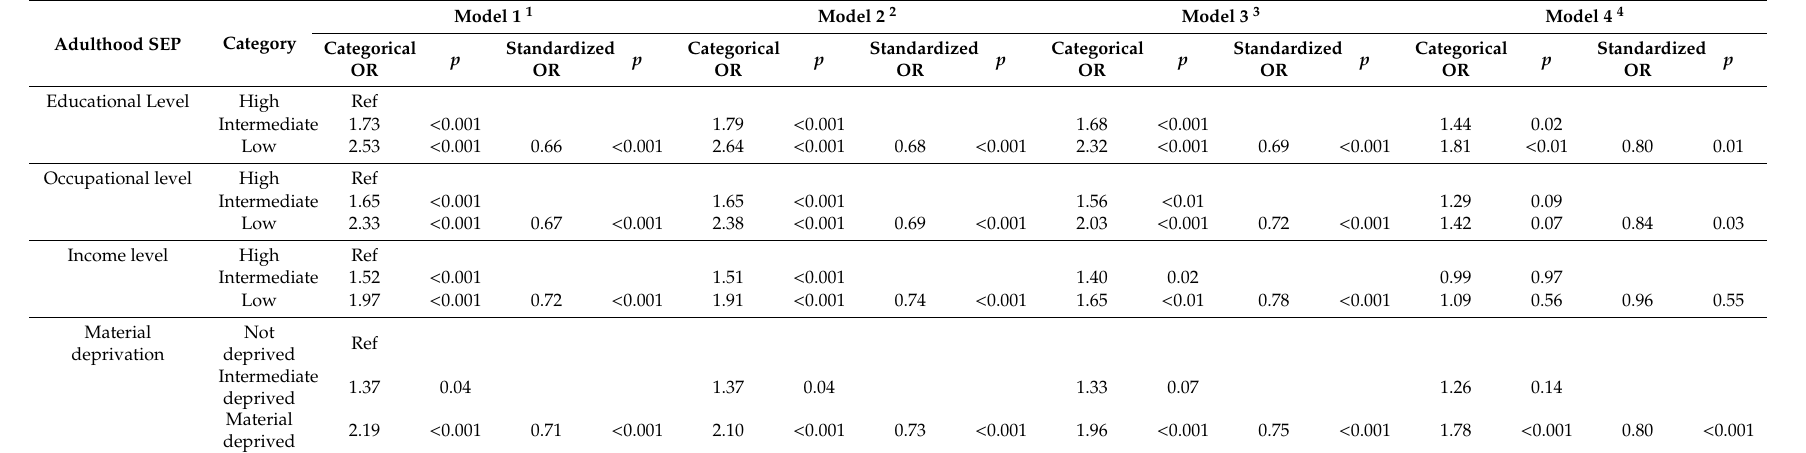
Table 3. Odds ratios of T2DM by educational level, occupational level, income level and material